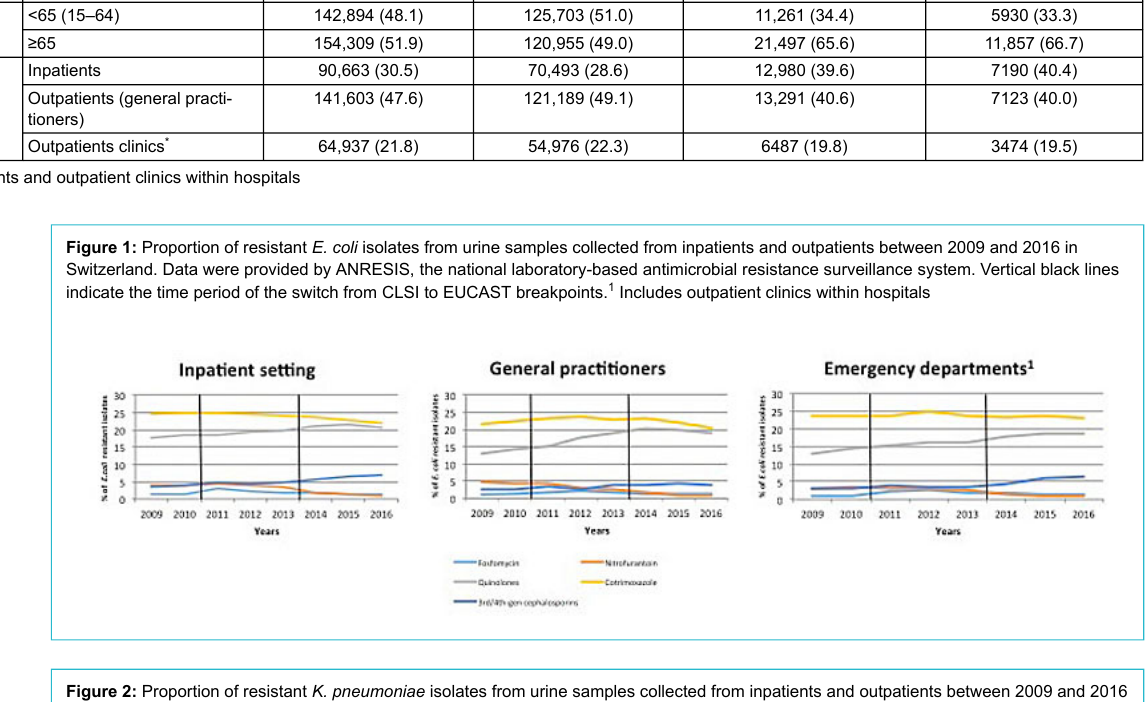
Figure 2: Proportion of resistant K. pneumoniae isolates from urine samples collected from inpatients and outpatients between 2009 and 2016 in Switzerland. Data were provided by ANRESIS, the national laboratory-based antimicrobial resistance surveillance system. Vertical black lines indicate the time period of the switch from CLSI to EUCAST breakpoints. 1 Includes outpatient clinics within hospitals